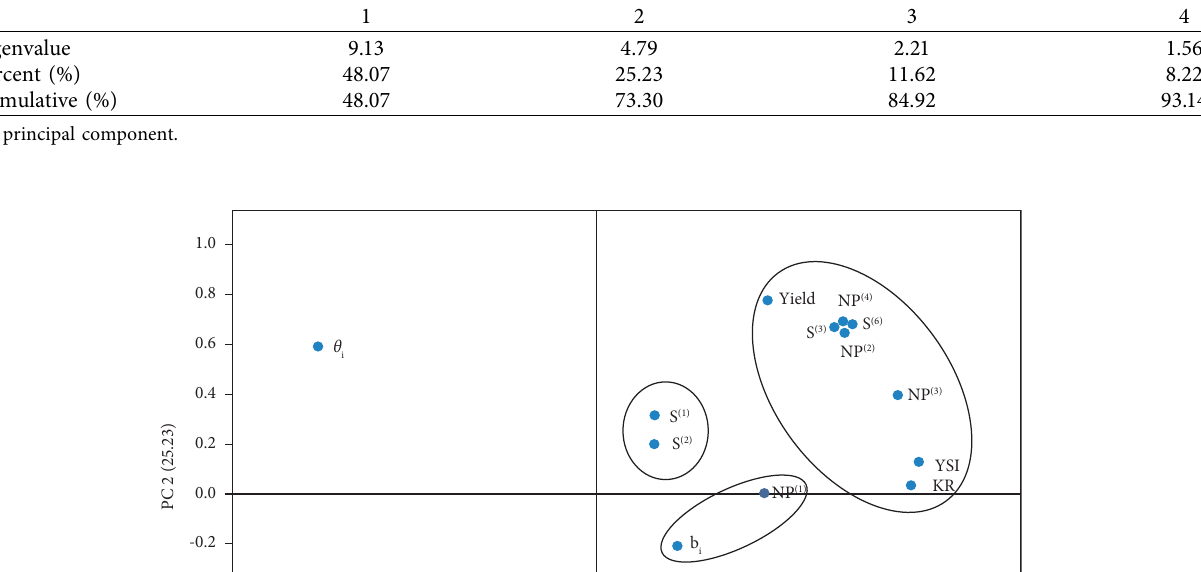
Table 6: Eigenvalue, percent, and cumulative of stability measurements.